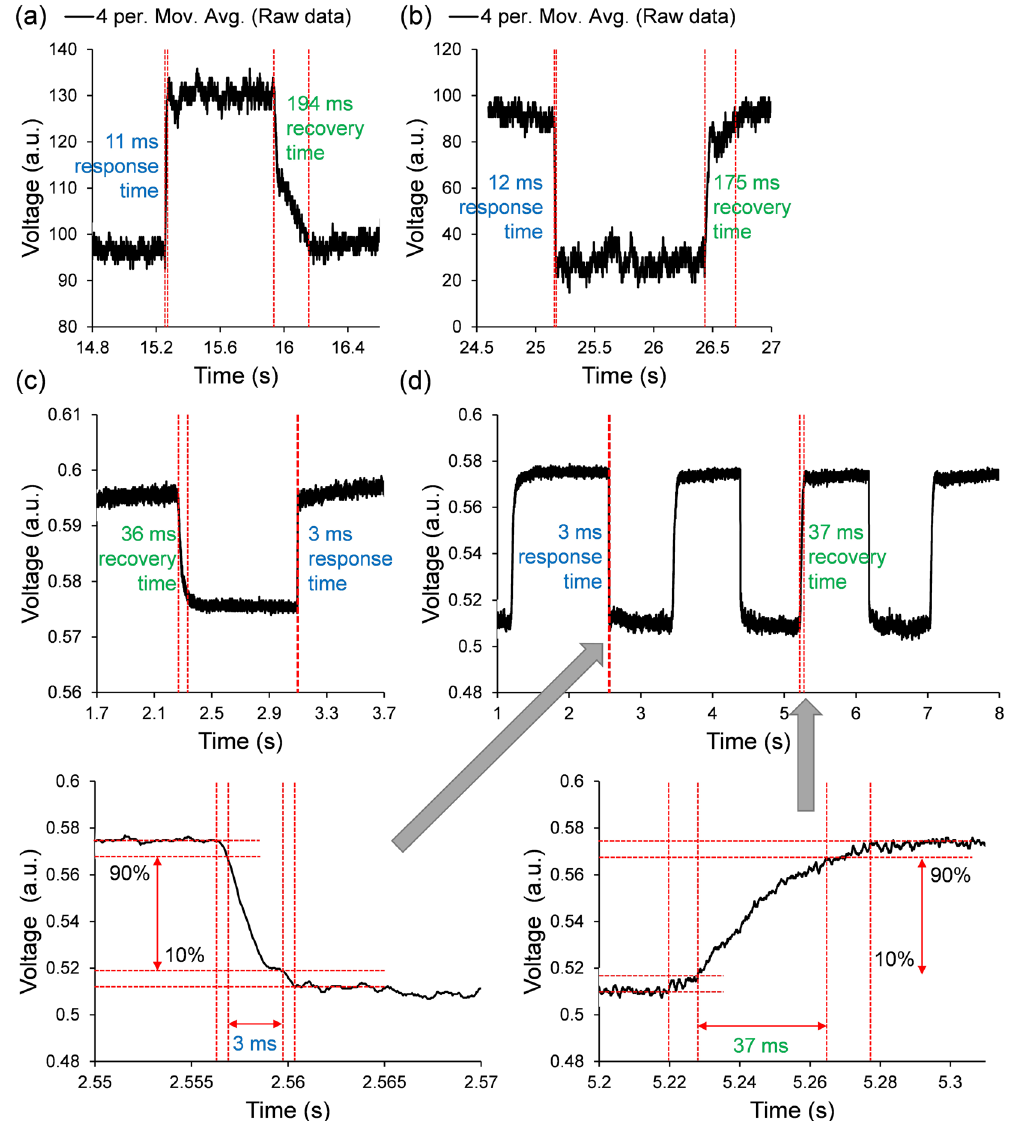
Figure 5. Temporal characteristics for: ( a ) 10.0 bilayer: 50–0–50%RH; ( b ) 10.0 bilayer: 50–99–50%RH; ( c ) 1.0 bilayer: 0–50–0%RH; and ( d ) 1.0 bilayer: